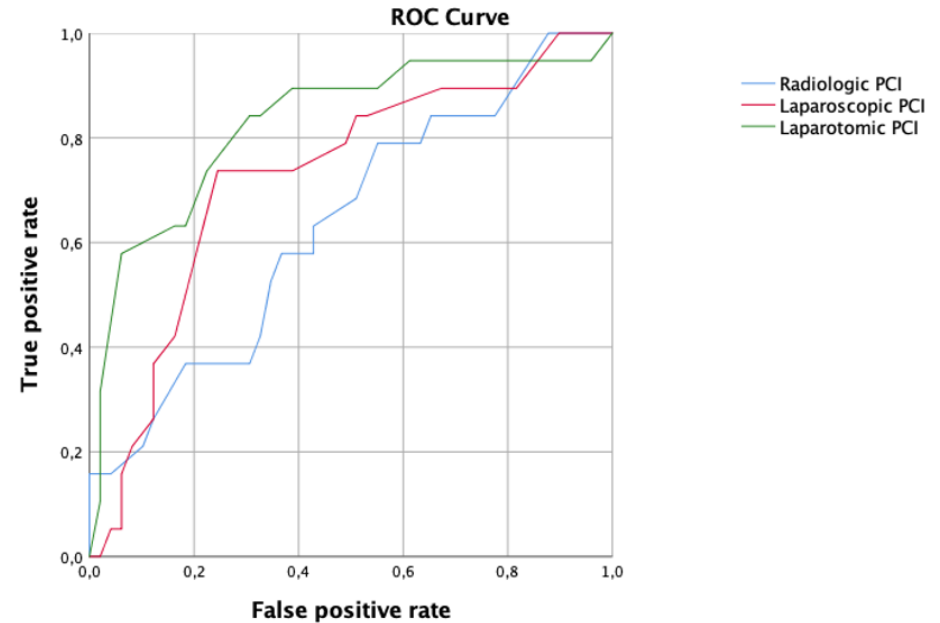
Figure 4. Receiver operating characteristic (ROC) curve comparing radiologic (blue line), laparoscopic (red line) and laparotomic (green line) peritoneal cancer index (PCI) in women who underwent primary debulking surgery.